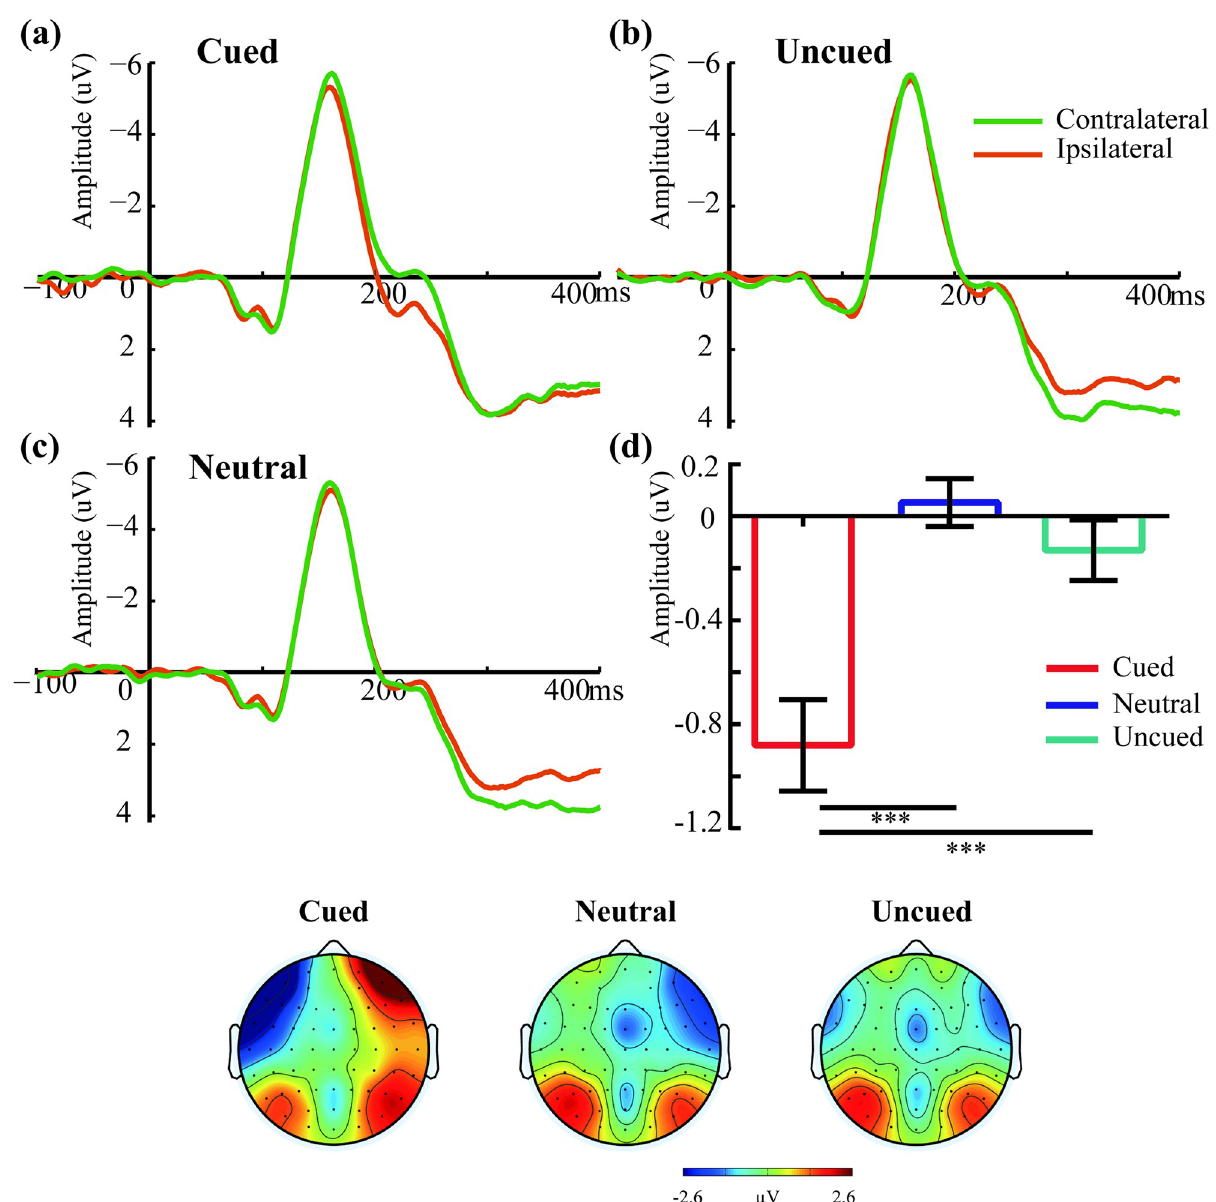
Fig 4. The N2pc waveforms (a, b, c) for contralateral and ipsilateral electrical activity and mean difference wave (d) are presented. Topography represents the N2pc component (170–250 ms). The left and right sides of the outline head represent ipsilateral and contralateral electrode sites of the target, respectively. ��� p <